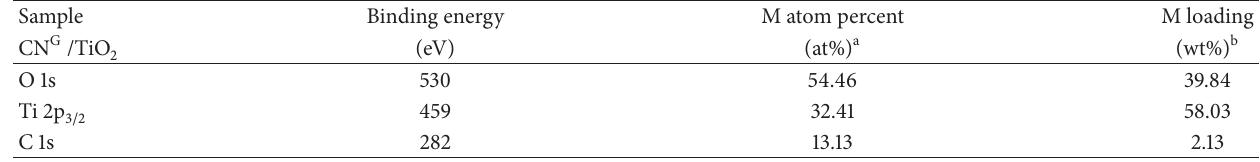
Figure 3: SEM images of (a), (b), and (c) CN G /TiO 2 . Table 1: Binding energies and surface element compositions of the CN G /TiO 2 .